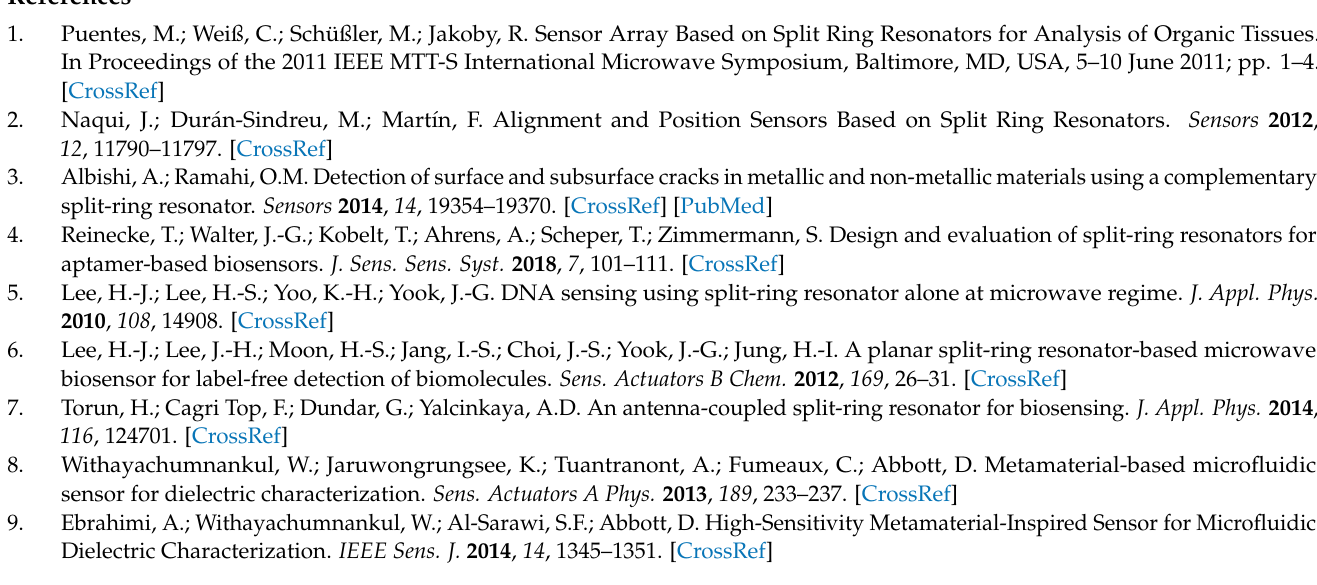
Figure A2. Frequency responses for different concentrations of glutamine (Gln) ( a ), glutamic acid (Glu) ( b ), histidine (His) ( c ), isoleucine (Ile) ( d ), and methionine (Met) ( e ) between 100 MHz and 400